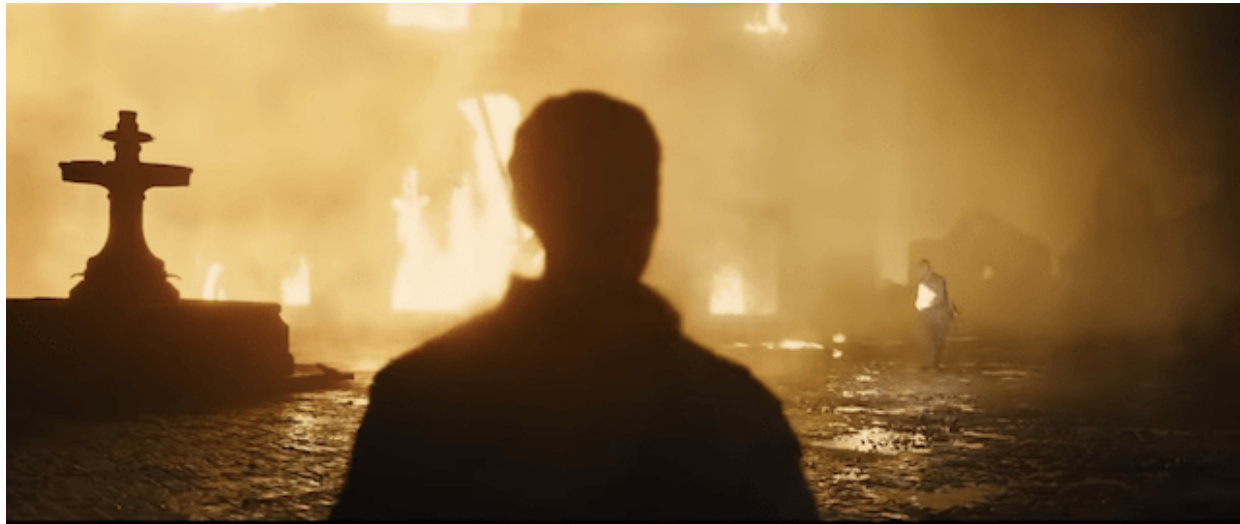
Figure 17. The muzzle of their gun flashes. Schofield is being attacked! (Screenshot created by author). But technical achievement does not necessarily equate with artistic accomplishment.